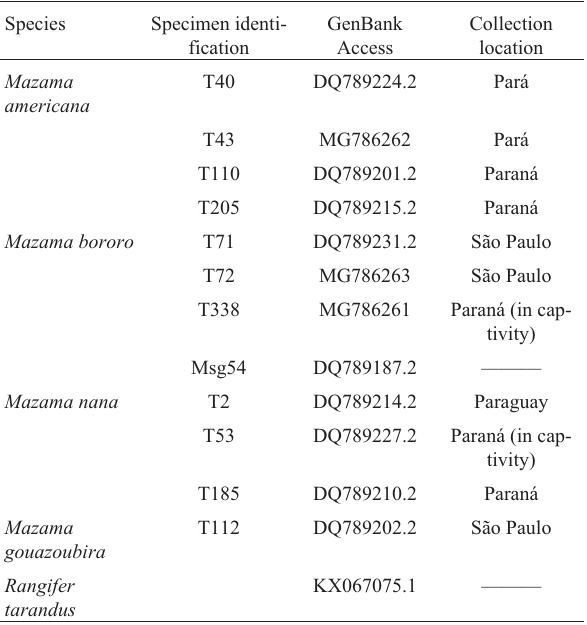
Table 2 - Sequences used for phylogenetic tree inference, detailing the sample origin as recorded from museum label collections with sequences from known identification and GenBank access